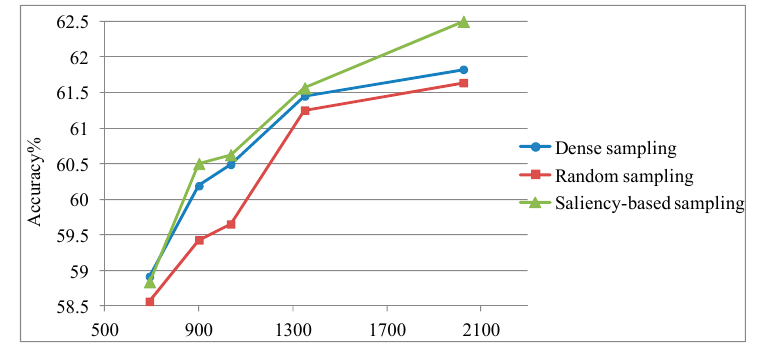
Figure 5. Comparisons of classification accuracy using different sampling methods at pyramid level 0 of STL-10 dataset.